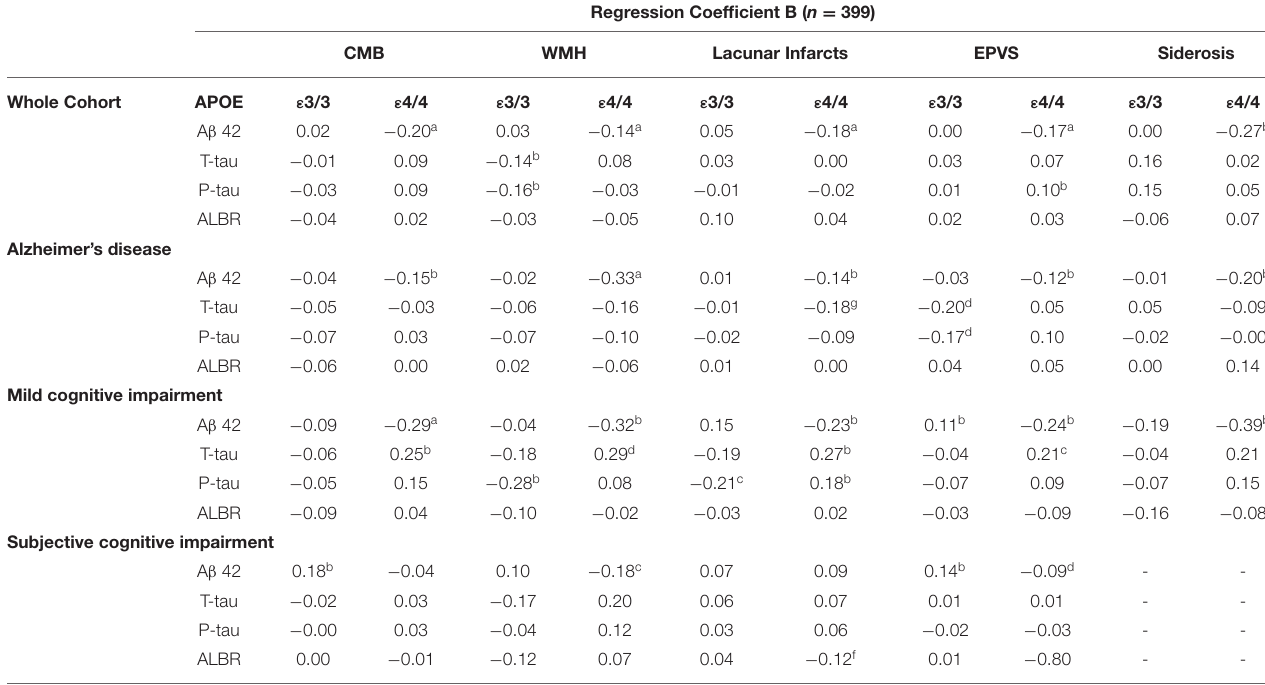
Linear regression analysis was performed with the CSF biomarker as a dependent variable and the presence of MRI marker and the APOE genotype of interest entered as one independent variable. The model was controlled for: the APOE genotype of interest, the MRI marker in focus, age, gender, dementia diagnosis, hypertension, hyperlipidemia, diabetes, andMRIfieldstrength.AllpatientswithCSFbiomarkerswereincludedinthisanalysis(n = 399).CMBs,lacunarinfarctsandsiderosisindicatesthepresenceofthesemarkers.WMHand EPVS are dichotomized values. In subjective cognitive impairment analysis for ε 3/3 was performed as before, however, due to small effect sized, analysis was performed for ε 4 carriers. ALBR, CSF/serum albumin ratio; CMB, Cerebral Microbleeds; EPVS, Enlarged perivascular spaces; WMH, White matter hyperintensities. a p < 0.001; b p < 0.05; c p = 0.05–0.06; d p = 0.06–0.07; d p = 0.07–0.08; f p = 0.08–0.09; g p =